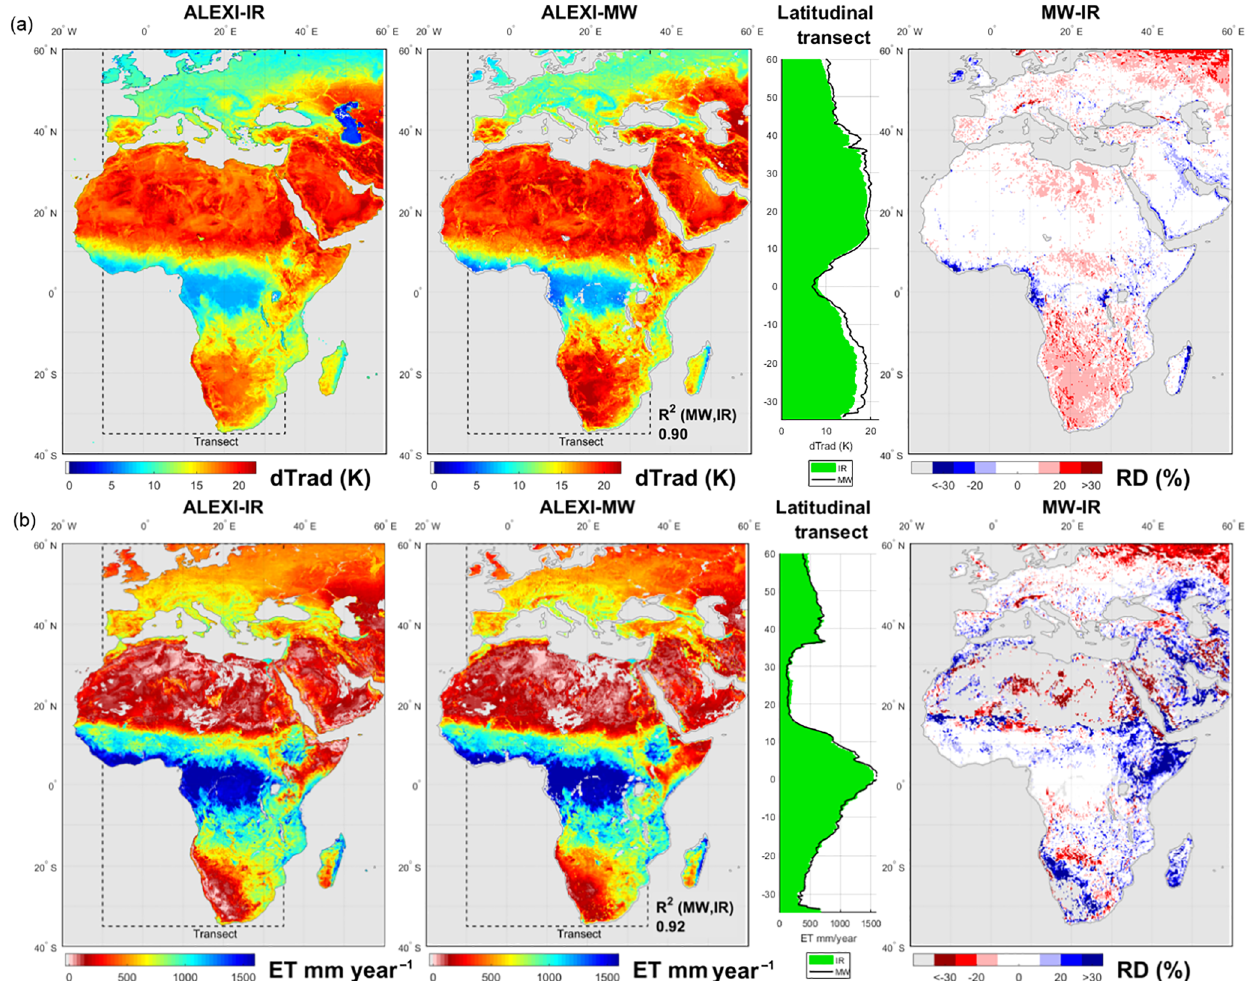
Figure 4. Multi-year mean of clear-sky (cid:49)T rad ( a , 2004–2011) and mean annual clear-sky ET ( b , 2003–2011) for IR and MW. The transect shows the latitudinal average for longitude 10 ◦ W to 35 ◦ E. The right-hand panel shows the corresponding relative difference (RD) between the two estimates (MW–IR), with areas with ET below 14mmmonth − 1 greyed out. Note the reversed color bars for (cid:49)T rad and ET to emphasize their negative correlation ( (cid:49)T rad up, ET down). (cid:49)T rad is defined in the ALEXI framework as the temperature rise between 1.5h after sunrise to 1.5h before noon (see Sect.